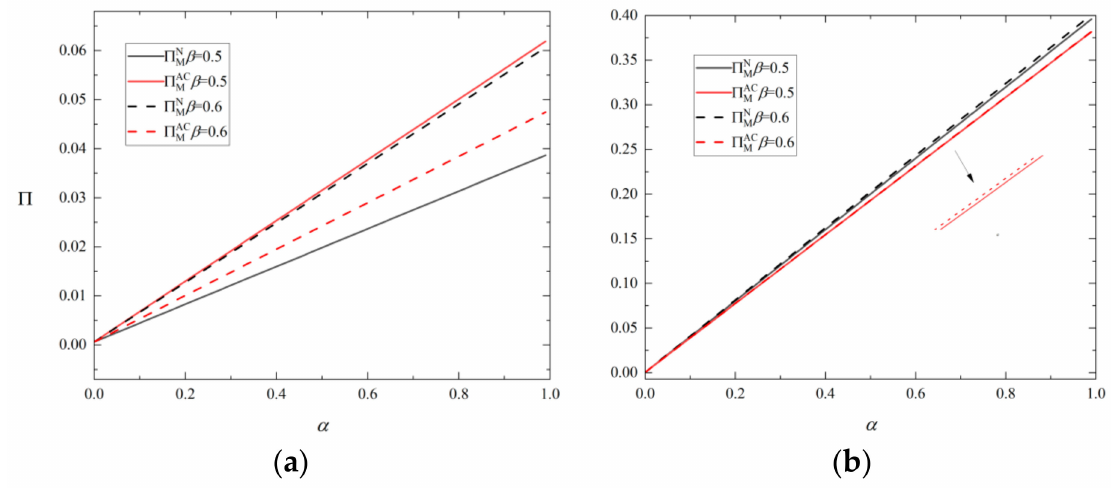
Figure 4. Impact of β on manufacturer profit. ( a ) s = 0.25; ( b ) s = 0.8. When β and s are small, Π AC ∗